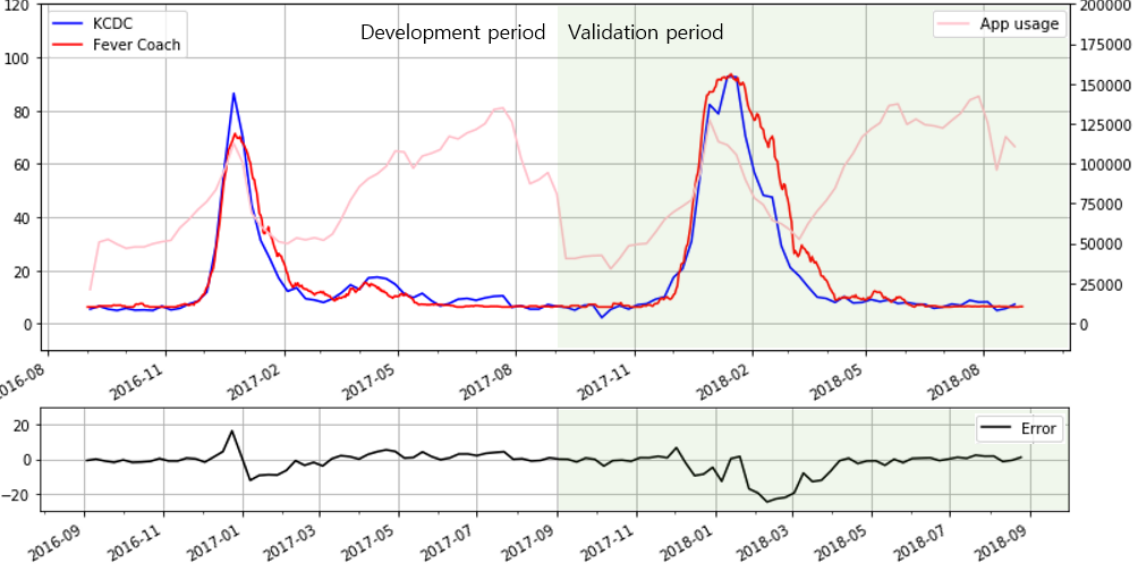
Figure 4. A comparison between Korea Centers for Disease Control and Prevention (KCDC) influenza-like illness (ILI) data and Fever Coach data: blue line shows ILI visits per 1000 outpatient visits reported by KCDC, red line shows ILI prediction from Fever Coach data, and pink line shows the total number of fever-related records in a week. Errors between P (t) and predicted values were displayed at the bottom plot as a black line. The development period was illustrated with a white background color, and green-colored background was used for the validation